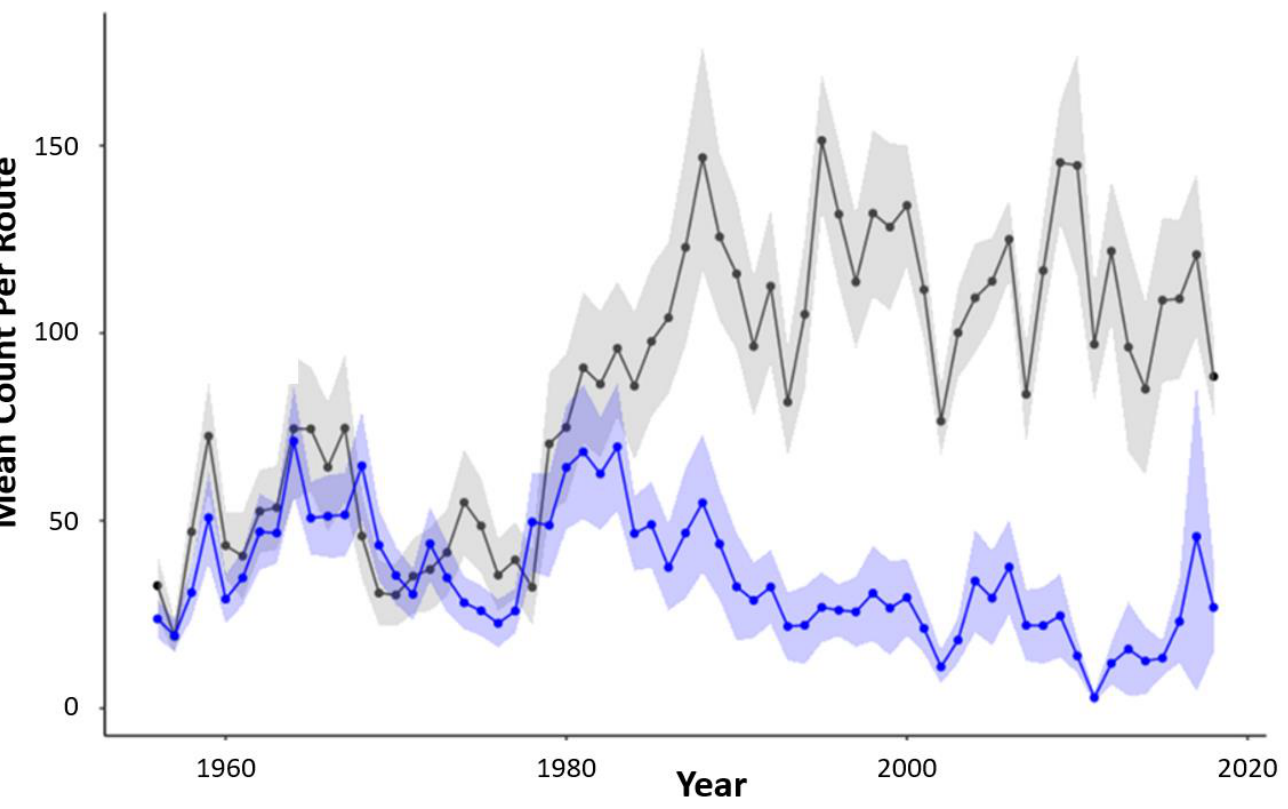
Figure 3. Mean number of male sharptails (blue line) and prairie-chickens (grey line) per breeding ground survey route from 1956 to 2018 in the Sandhills of Nebraska, USA. Trend lines are shown with 95% confidence intervals.